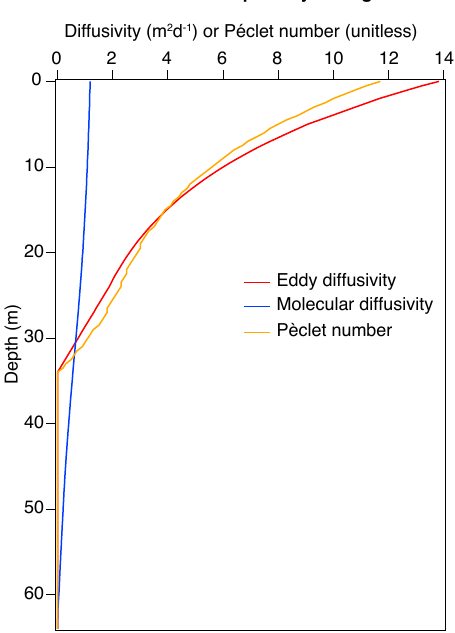
Fig. 4. Depth profiles of transport parameters found at Megadunes by fitting to data. Eddy diffusivities and molecular diffusivities are in units of m 2 day − 1 for ease of comparison with the Péclet number. Numerical integration of this Péclet number allows calculation of the kinetic fractionation via the simple